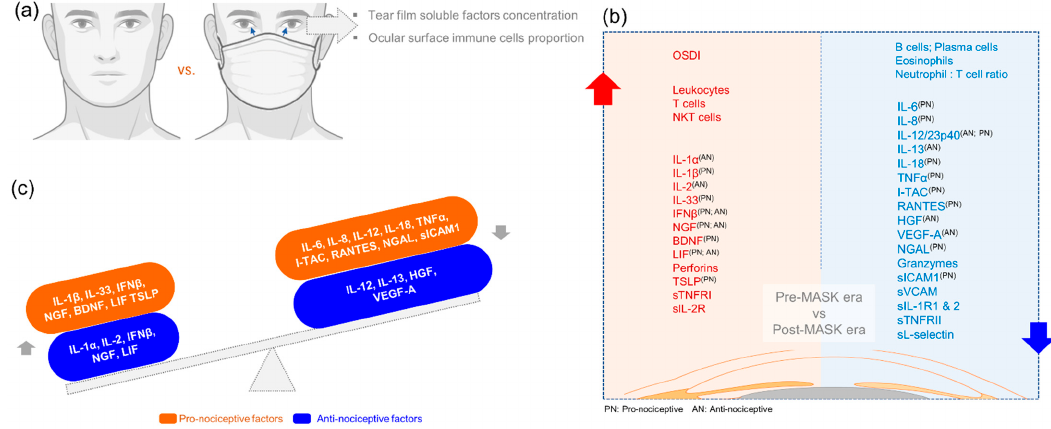
Figure 7. Schematic summary of the status of ocular surface clinical indices, proportion of immune cell subsets and tear fluid soluble factor levels during the face-mask-wearing era. Panel ( a ) is a schematic representation of the study design. Left side (red zone) of panel ( b ) summarises the list of clinical indices, immune cell subsets and tear soluble factors that increased during the post face mask era compared to the pre face mask era in matched subjects. Right side (blue zone) of panel ( b ) summarises the list of immune cell subsets and tear soluble factors that decreased during the post face mask era compared to the pre face mask era in matched subjects. Since ocular surface discomfort was one of the main clinical indices that was significantly high, we categorised the tear soluble factors based on their ability to modulate nociception in order to study the relationship between tear soluble factors and the discomfort experienced by the study subjects during the post face-mask-wearing era. Superscript of PN and/or AN beside the various analytes indicates whether they possess pro-nociceptive (PN) or anti-nociceptive (AN) potential as reported in the literature and not limited to ocular surface pain. Panel ( c ) demonstrates that both pro- and anti-nociceptive factors were dysregulated in tear fluid during post face-mask-wearing era. However, it can be posited that an increase in a select set of pro-nociceptive factors (IL-1 β , IL-33, IFN β , NGF, BDNF, LIF and TSLP) and a decrease in a select set of anti-nociceptive factors (IL-12, IL-13, HGF and VEGF-A) could contribute to ocular surface discomfort without changes in tear fluid dynamics during the post face-mask-wearing